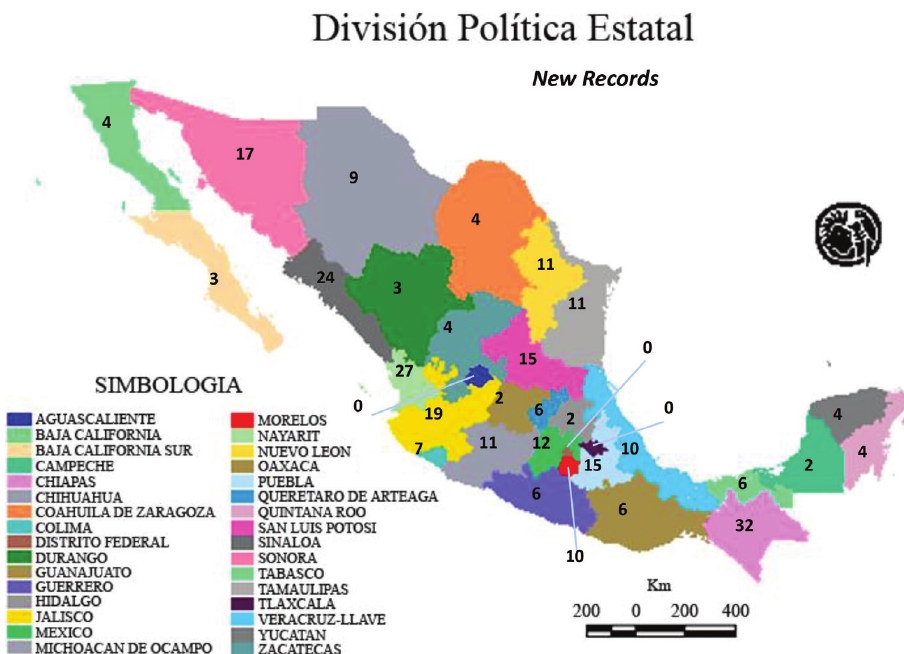
Map 2. New species records by states from the current